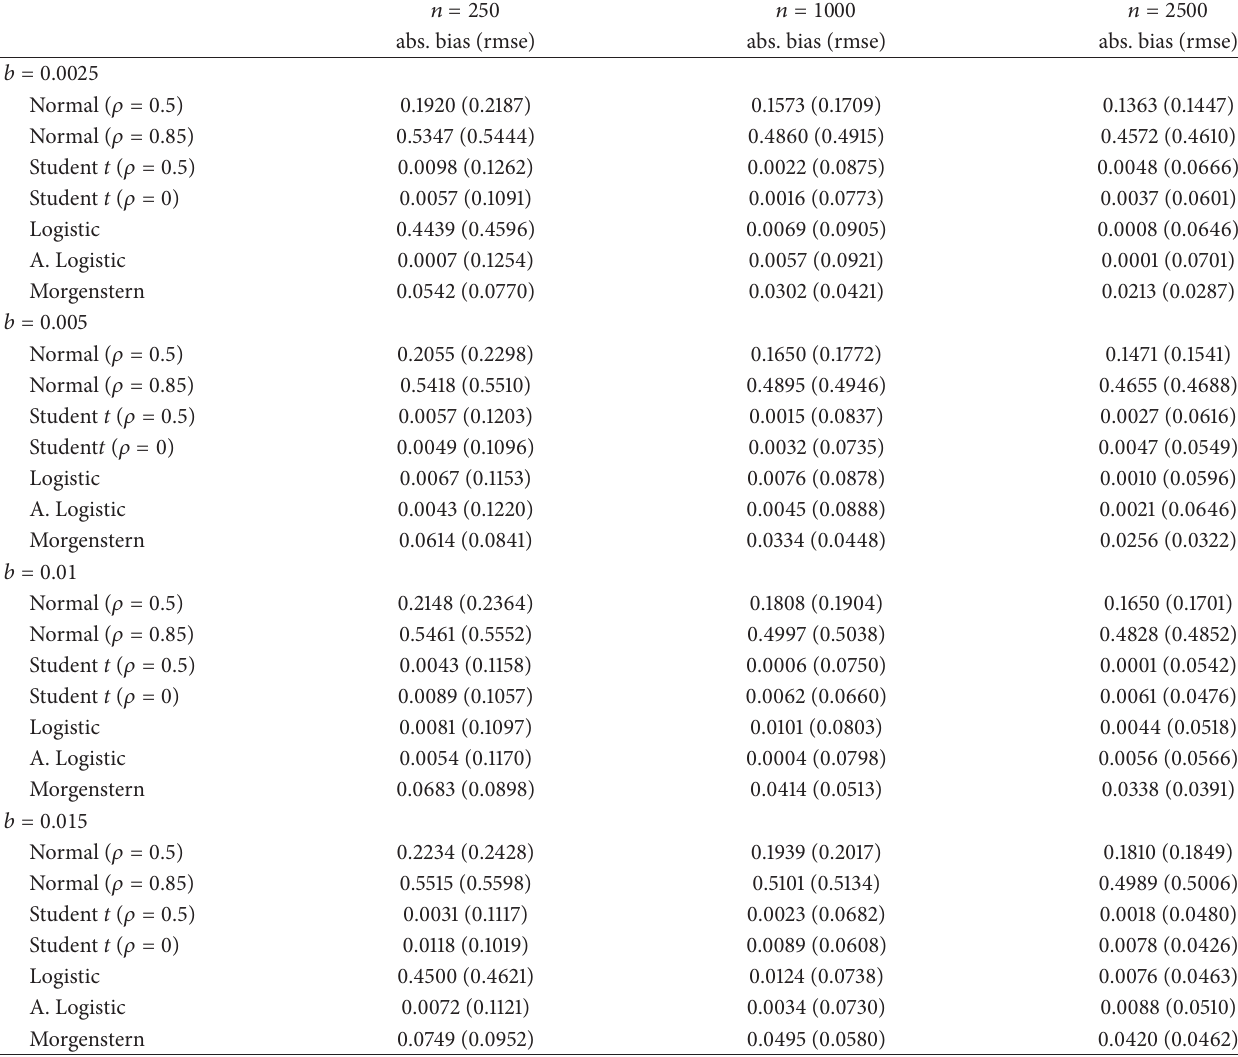
Table 1: Absolute bias and root mean squared error (rmse) of estimator